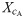
Relationships between cranio-caudal (NCC) and medio-lateral (NML) navicular displacement.(a) Averages among participants with standard deviations for NCC and NML during the stance phase (SP). Corresponding ranges of motion are given in Table 2. The blue parts represent the absorption and the red parts the generation phases. (b) Displacement-displacement diagram of mean NML versus mean NCC with median cross-correlation coefficients for the whole stance phase (Xc), the absorption phase (XcA) and the generation phase (XcG) in the title. (c) Scatter plots of cross-correlation coefficients for the whole stance phase (Tot), the absorption phase (Abs) and the generation phase (Gen) from all participants for the relation between NCC and NML. Large markers represent the medians. (d) Distribution of the cross-correlation coefficients among the strong, moderate and weak classes (values given in Table 3).